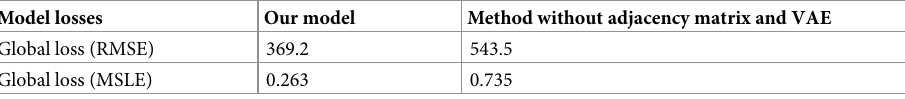
Table 1. The impact of the spatially-weighted adjacency matrix on the model prediction.